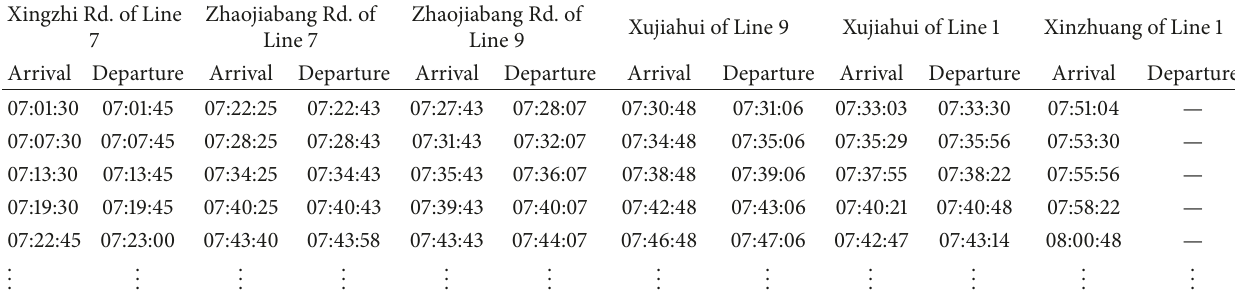
Table 6: The real timetable of trains on Route 3.